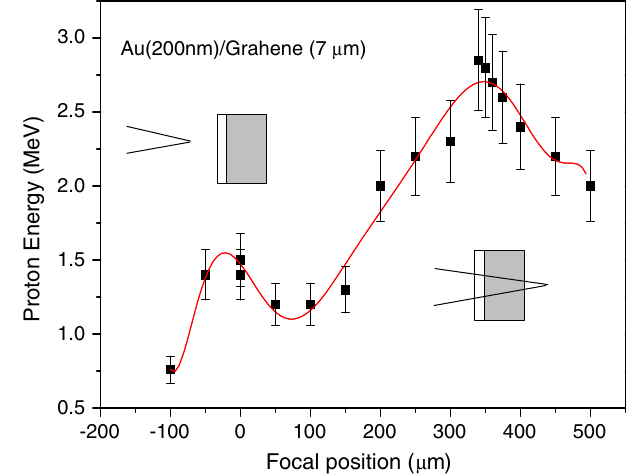
FIG. 7. Experimental maximum proton energy as a function of the laser focal